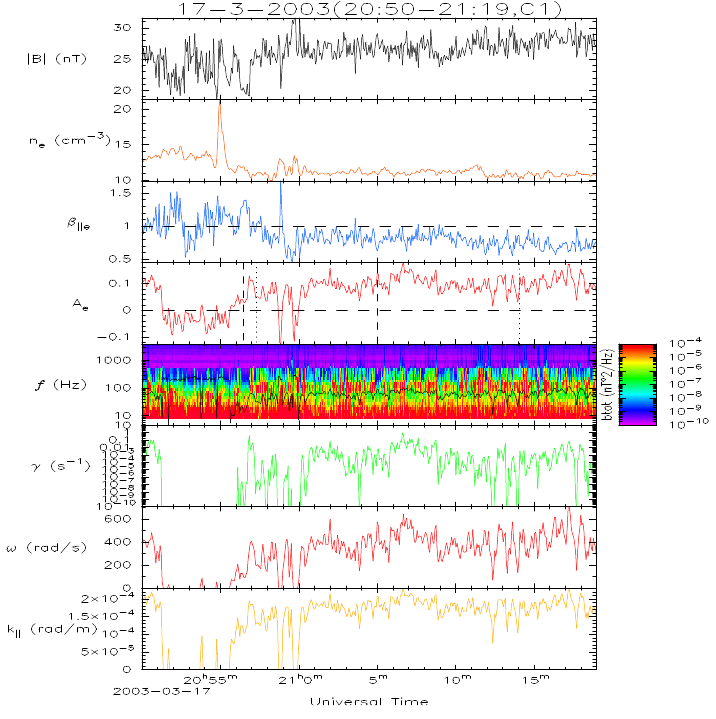
Fig. 2. From 20:50 to 21:19 UT on 17 March 2003 on C1. Format as in Fig. 1.